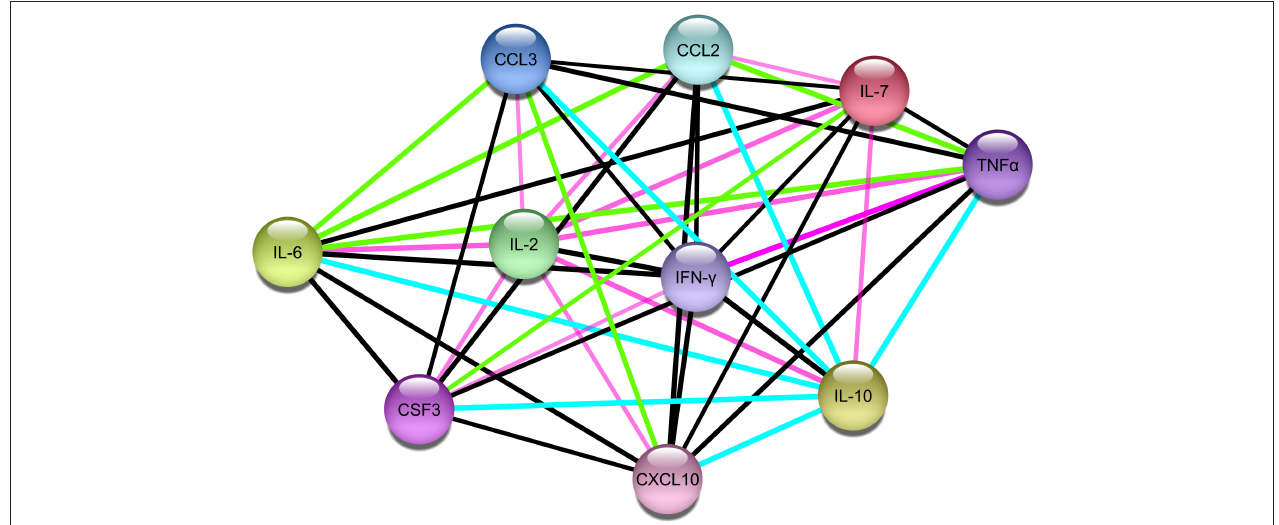
FIGURE 2 | Protein-protein interaction network of the 10 cytokines associated with COVID-19 cytokine storm (Edge color legend; blue: from curated database; pink: experimentally determined; green: text mining; black: co-expression).